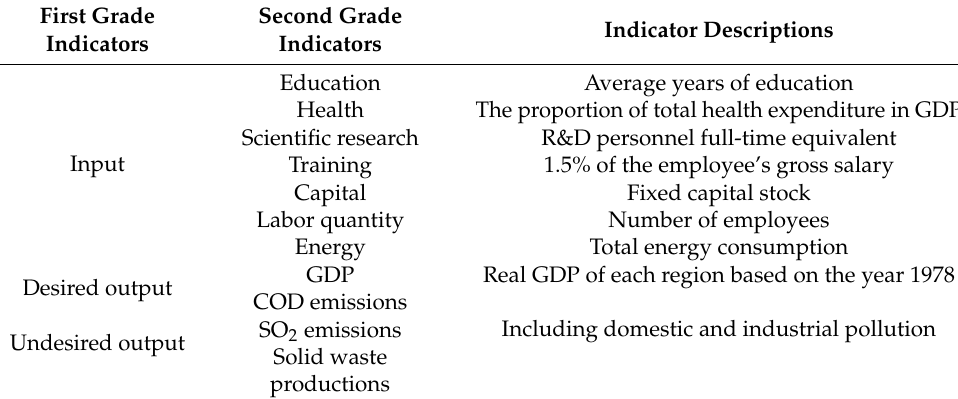
Table 2. Input-output index